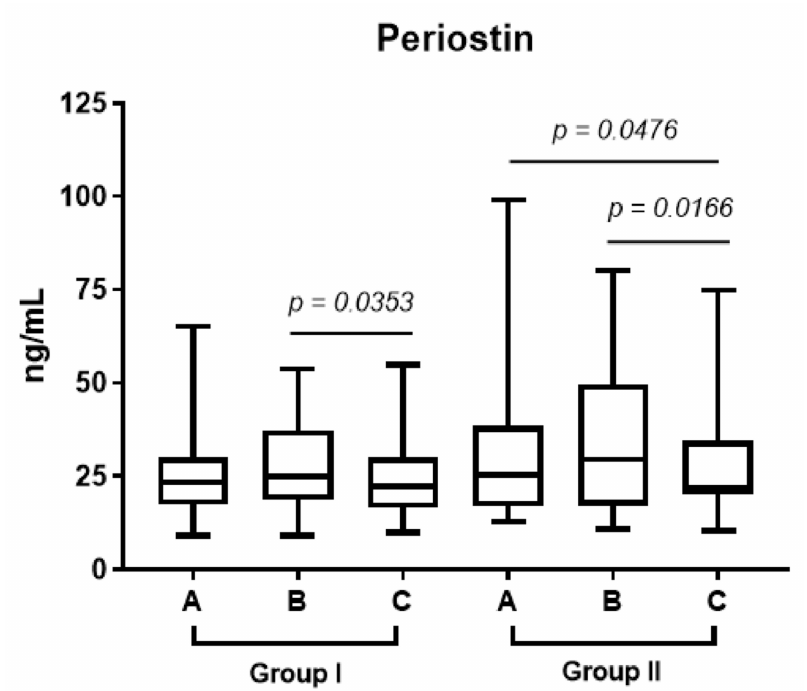
Figure 2. The median level of periostin in plasma one week before operation (point A), after admission to the hospital (point B) and 1 month after FESS (point C) in groups 1 and 2.